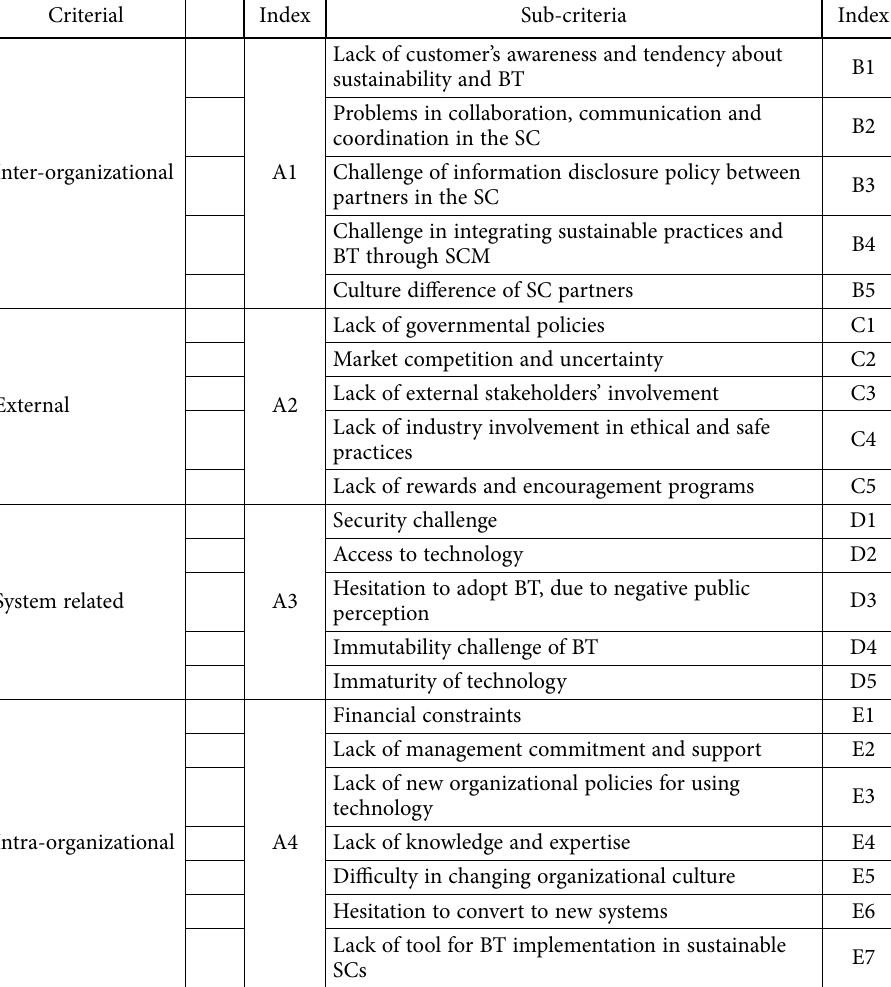
Table 1. Barriers to using Blockchain Technology in sustainable SCs (Saberi et al., 2018)